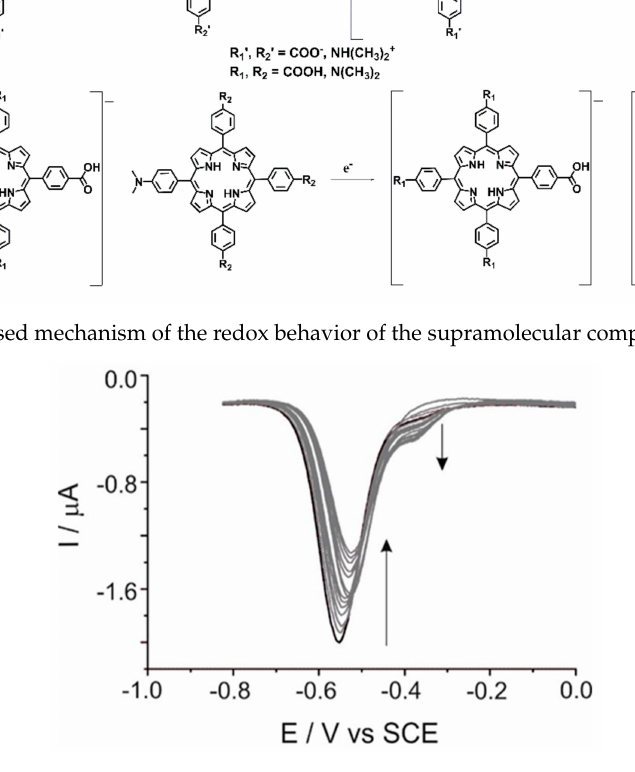
Figure 4. Di ff erential pulse voltammograms of TDAP (solid black line) and the corresponding evolution of the redox signal with increasing amounts of TCPP (solid gray lines). Scan rate of 10 mV s − 1